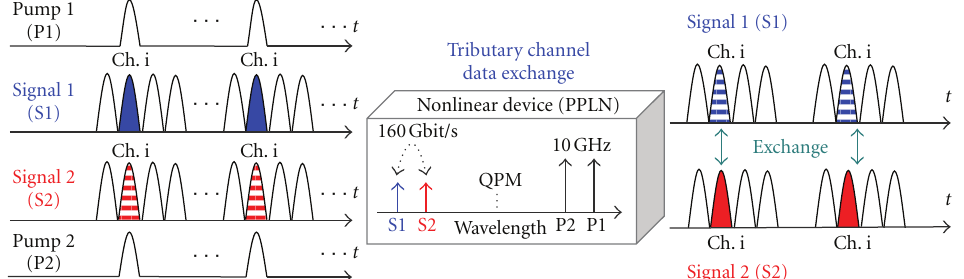
Figure 7: Concept and principle for single-PPLN-based tributary channel exchange between two WDM high-speed OTDM